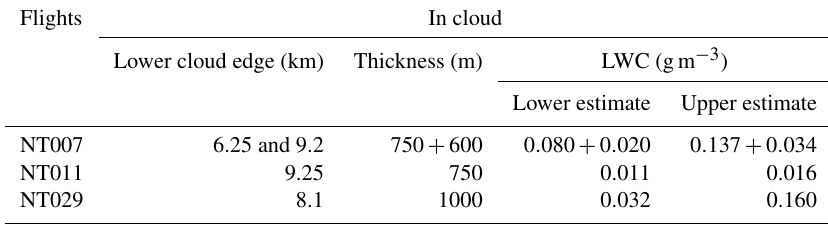
Table 1. Lower cloud edge, thickness of cloud fraction containing supercooled liquid droplets, and estimated liquid water content (LWC) in mixed-phase clouds for flights NT007, NT011 and